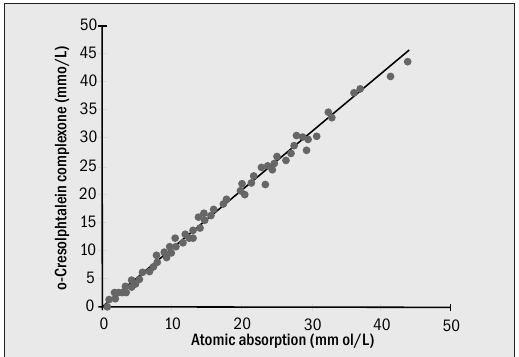
Figura 2 – Linear regression obtained with 135 urine samples (range = 0.15 to 11.0